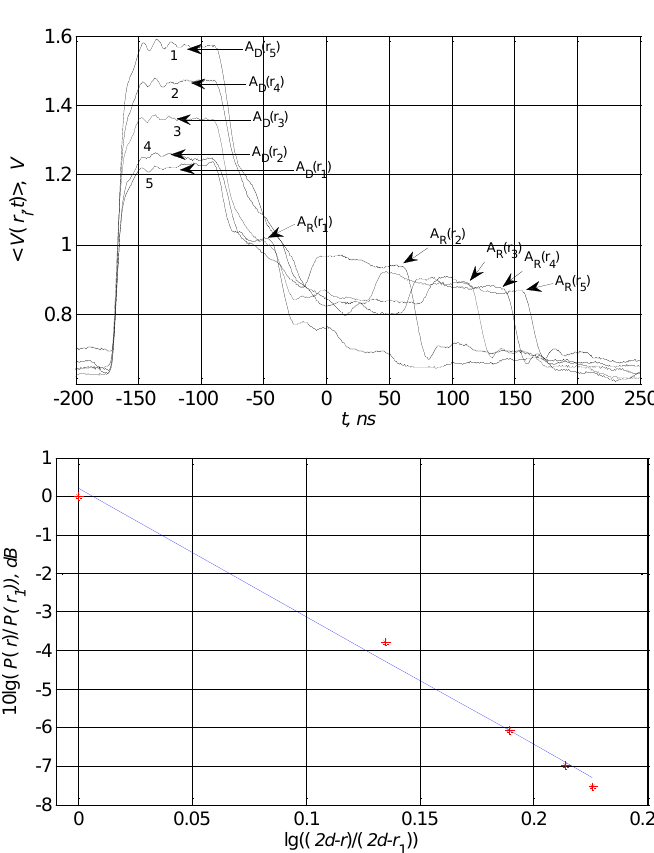
Fig. 2. (a) Average pulse envelope waveforms  ),( trV i , on which the average amplitudes of the direct  )( iD rA and reflected  )( iR rA paths recorded by the receiver at distance the emitter for pulses with 100-mW power are marked:  )2( 5 rA R = 0.85 V (curve 1),  )4( rA = 0.86 V (curve 2),  )8( 3 rA R = 0.88 V (curve 3),  )16( 4 R rA (curve 4),  )32( = 1.01 V (curve 5) ; and (b) a plot of the power ratio P ( r ) / P ( r 1 ) for the 1 R reflected path in dB as a function of the distance ratio lg((2 d – r ) / (2 d – r results, solid line is